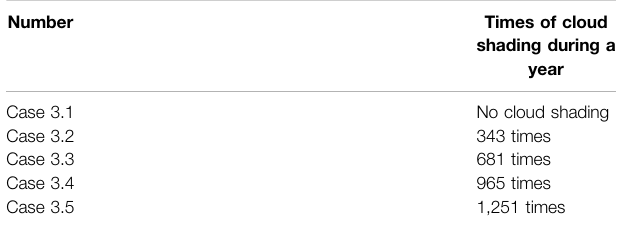
TABLE 6 | Case settings for the partial shading by clouds. Number Times of cloud